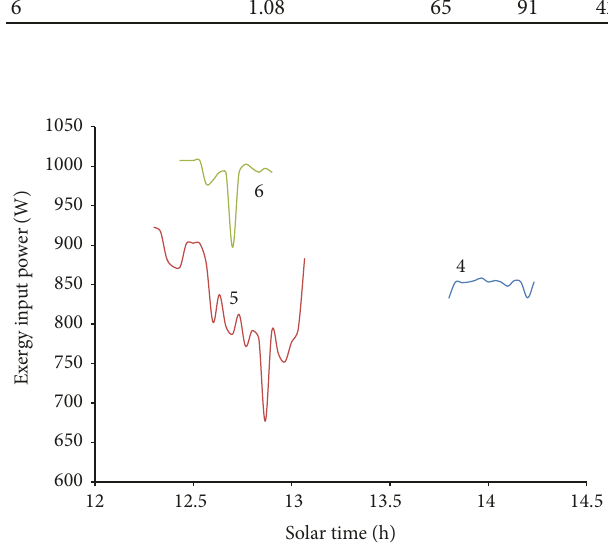
Figure 19: E ffi ciency of the exergy output power during the three experiments with 4kg water load. Blue points correspond to experiment number 4, red to experiment number 5, and green to experiment number 6.